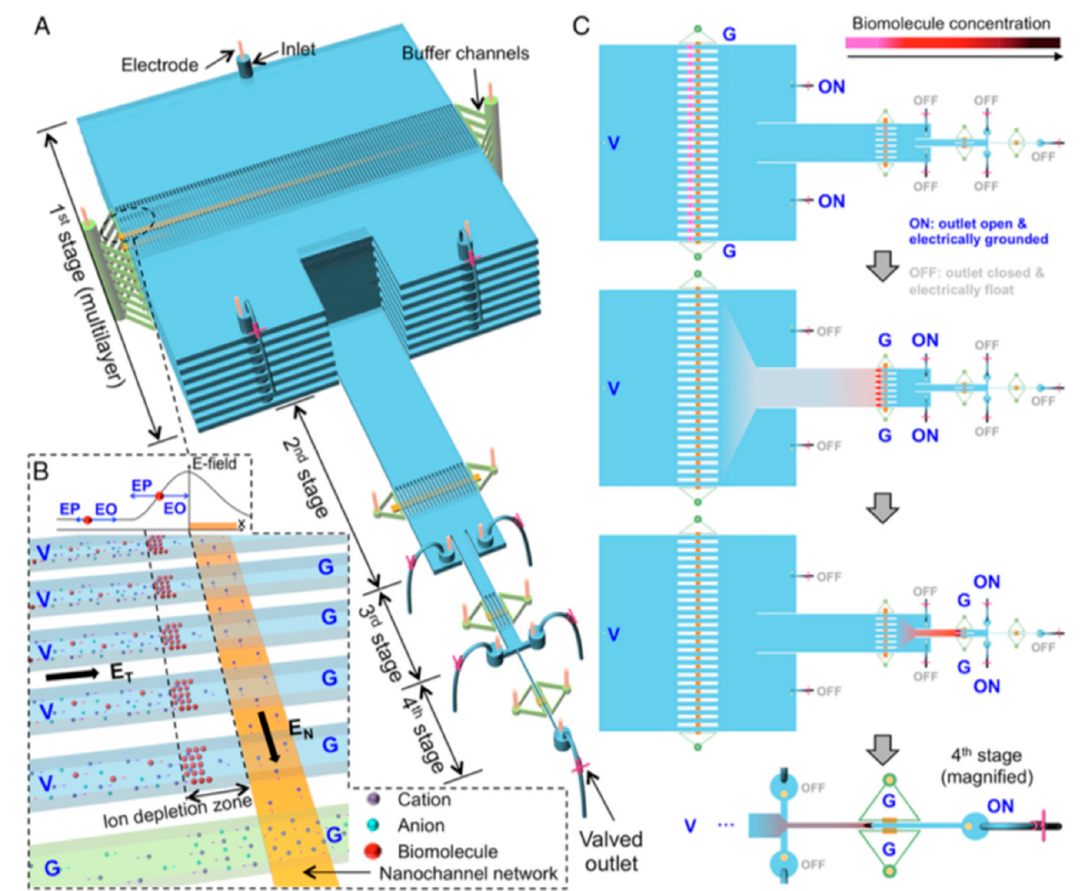
Figure 4. Principle of HOLMES [34]. ( A ) Schematic of HOLMES with hierarchical multistages. At each stage, parallel microchannels and buffer channels are bridged by a thin nanochannel network patterned on the bottom of the microchannels. ( B ) Schematic of nanofluidic biomolecule concentration in massively parallel channels. Under the electrical configuration shown, biomolecules are electro-osmotically injected into the parallel channels and electronically concentrated in the ion deletion zones induced near the micronanochannel junctions. V—voltage; G—grounded; EN and ET—normal and tangential electric fields, respectively; EO—electroosmosis; EP—electrophoresis. ( C ) Schematic of relayed reconcentration of biomolecules from massively parallel microchannels into a single microchannel to dramatically boost the concentration performance.